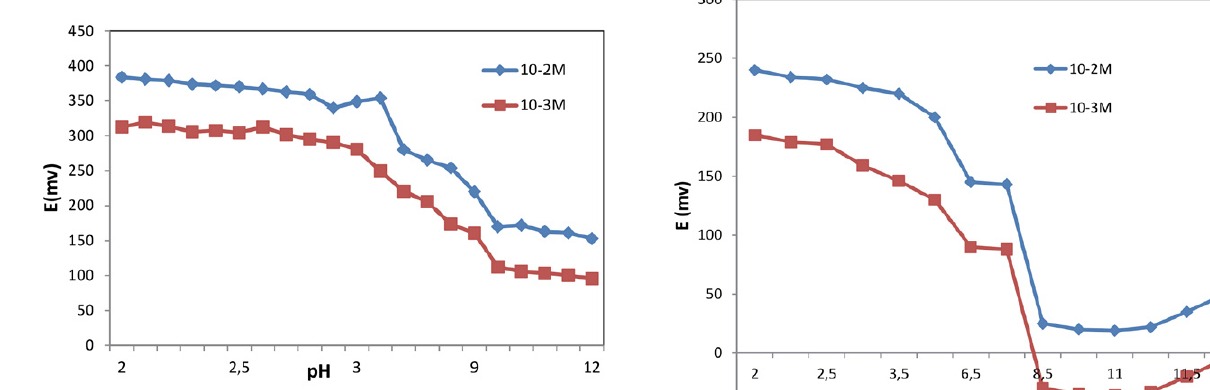
Fig. 3. Effect of pH on the response of Lab sensor 1a